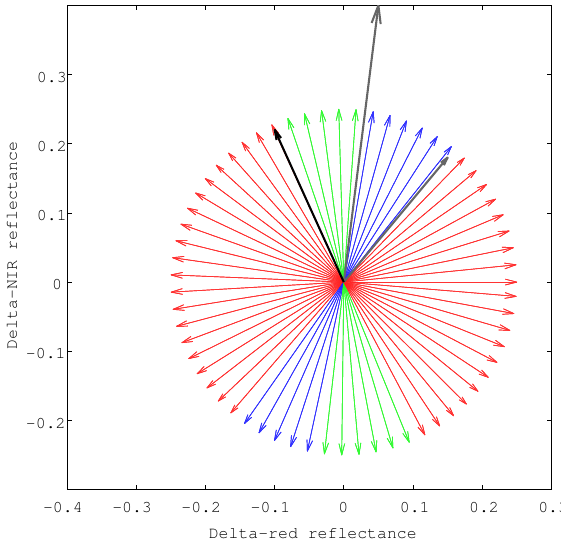
An example numerical demonstrations of the relationships between the endmember spectra and the monotonic behavior of the area-averaged FVC. ∆ˆ ρρρ was varied from 0 to 2 π in 0.10 radian increments. The initial point and the length of the vectors were assumed to be (0 , 0) and 0.25, respectively. ∆ ρρρ is indicated by black arrows, and the vector defined by the assumed endmember spectra, ∆ˆ ρρρ , is indicated by the colored arrows. Gray arrows indicate ρρρ and ρρρ . The vectors indicated in green correspond to non-decreasing v s trends in the averaged FVC ( 0 ≤ ζ < 1 ). The red arrows indicate that ζ falls into the class of non-increasing functions ( ζ > 1 ). The blue arrows indicate non-monotonic case ( ζ < 0